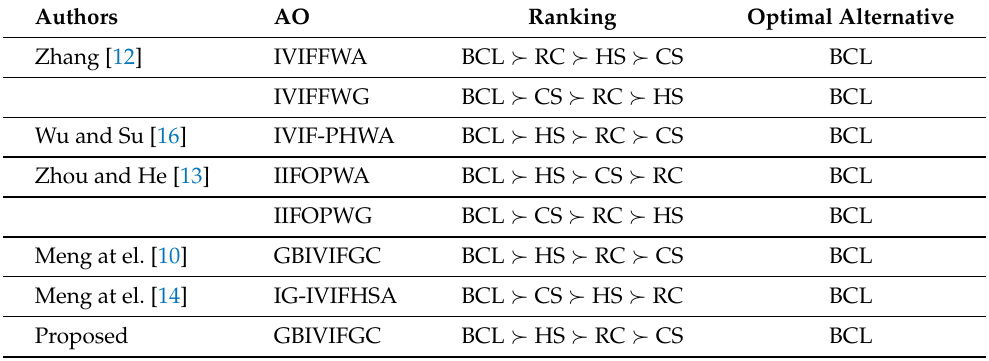
Table 7. Comparison of proposed operators with some existing